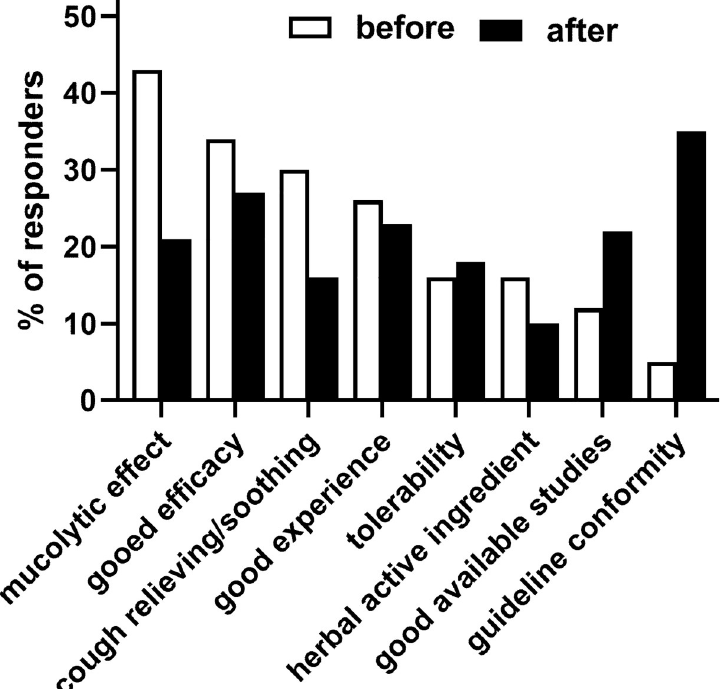
Fig 2. Stated reasons underlying the top-3 recommendation for the presented case as provided before and after having been shown excerpts of an applicable guideline. Data are shown as % of responders naming an option as part of top-3 recommendations. Note that the typical case presented to GPs differed somewhat from that presented to pharmacy